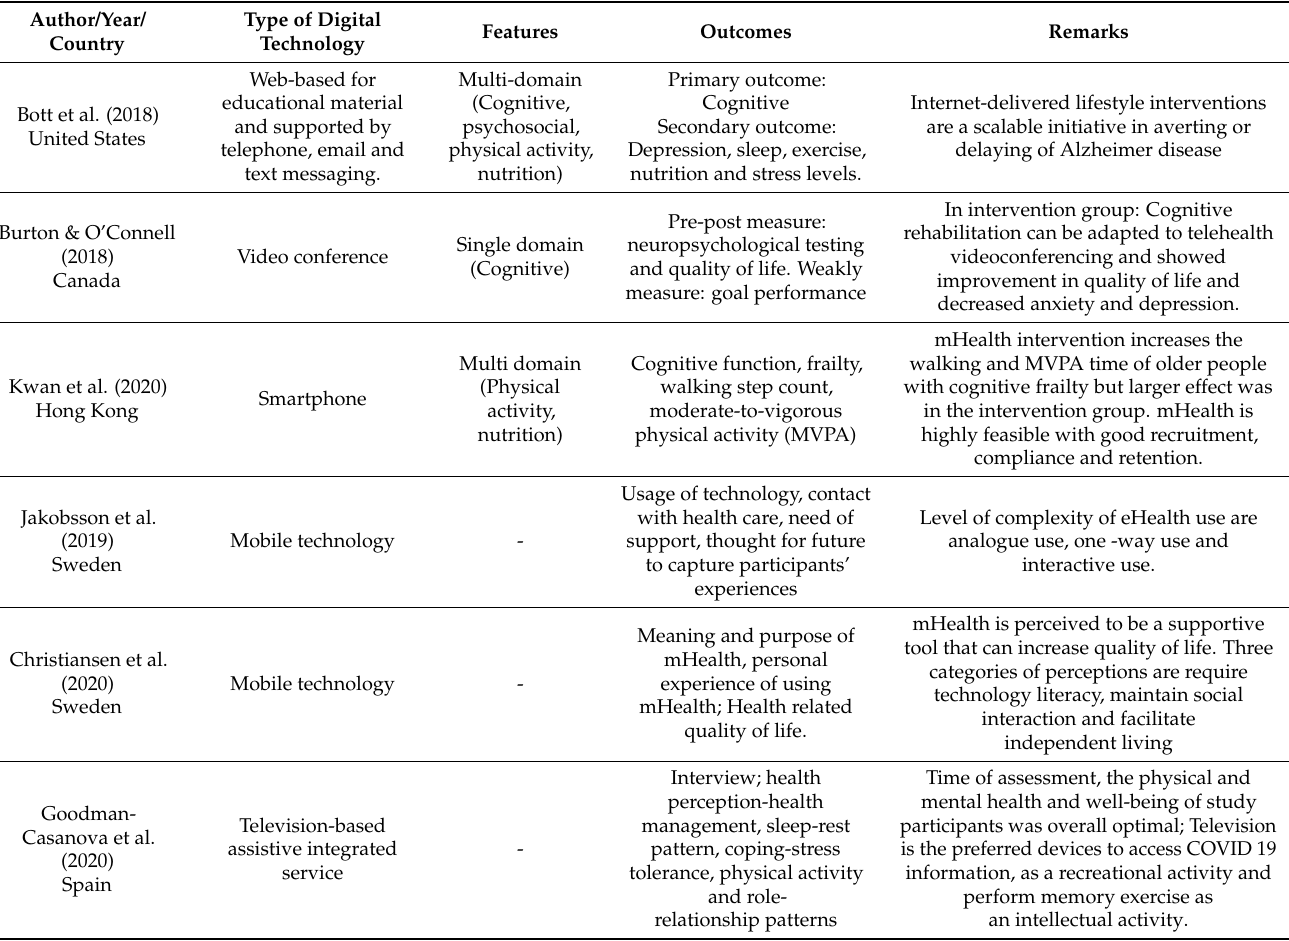
Table 3. Type of digital technology, the features and outcome measures of the selected